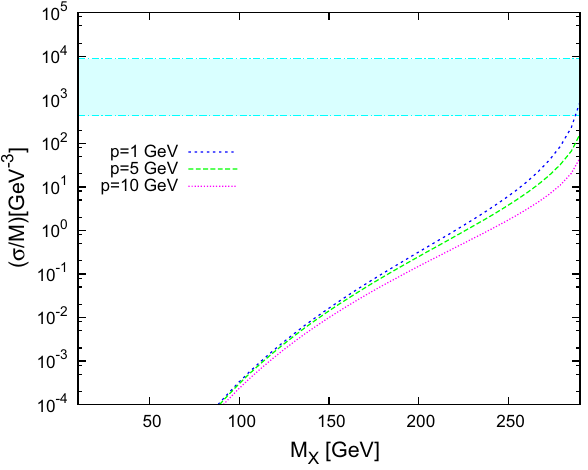
Fig. 11 The scalar–fermion self-interaction cross section as a function of the fermion DM mass. We set M s = 500 GeV and g = 0 . 5 λ φ s = 0 . 5, λ s = 0 . 5 and different values for the momentum of the initial fermionic DM. The shadowed panel indicates the allowed range of the experimental measurements for the DM self-interaction